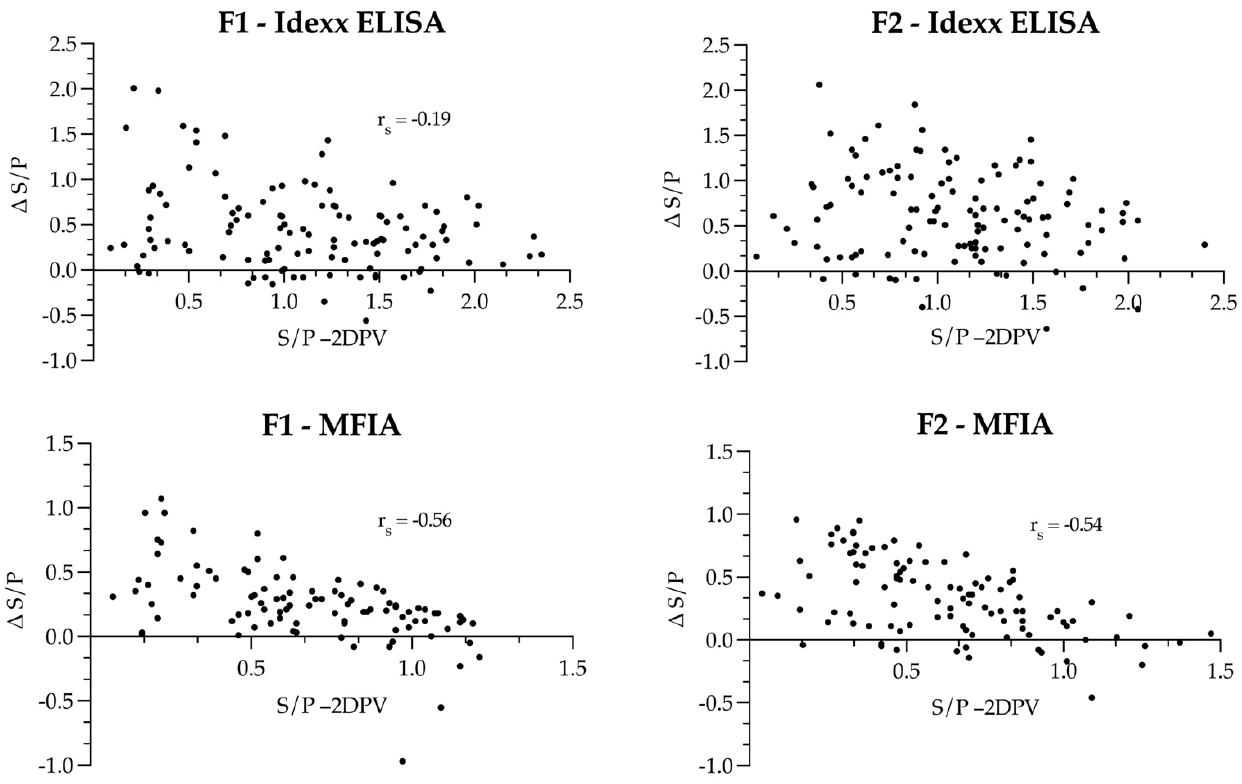
Figure 2. Scatterplots with difference in S/P ratio before and after mass vaccination ( ∆ S/P) plotted against the S/P ratio before vaccination ( − 2DPV) of both Idexx ELISA and MFIA( − 2DPV) on Farm 1 (F1) and Farm 2 (F2). Correlation coefficients for the monotonic relationship are given as rs in each figure.